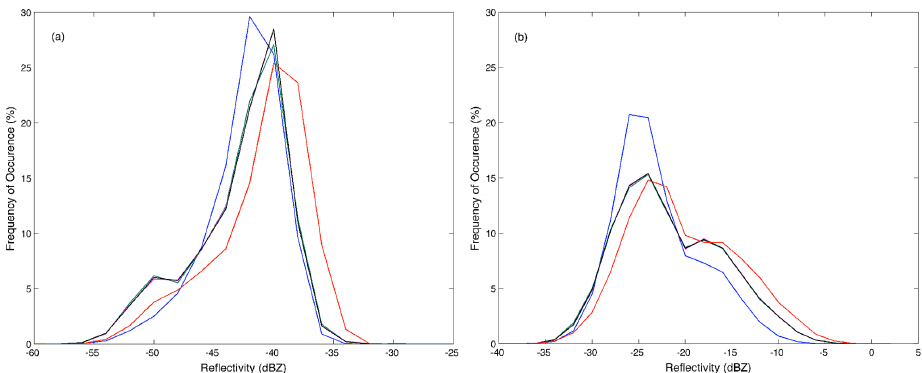
Fig. 6. Area distribution histograms of Ka-SACR radar reflectivity 2-D gridding for (a) a stratus cloud ( 1x = 25m, 1z = 25m) and (b) a cirrus cloud ( 1x = 50m, 1z = 50m). The radar reflectivity histograms are shown for the polar coordinates Ka-SACR post-processed data (blue) and for all interpolation schemes (Cressman: green; Barnes: black; maximum: red; and mean: